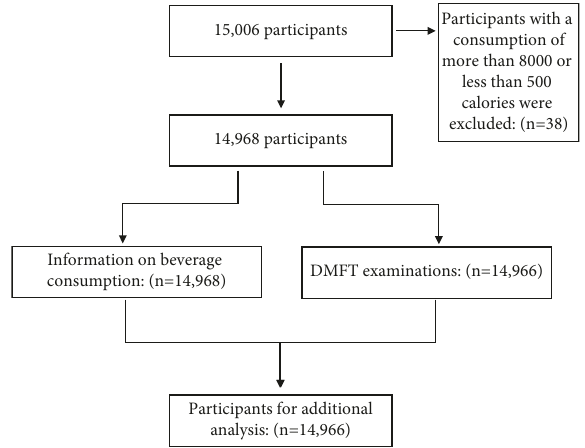
Figure 1: Flow chart for study stages and participant